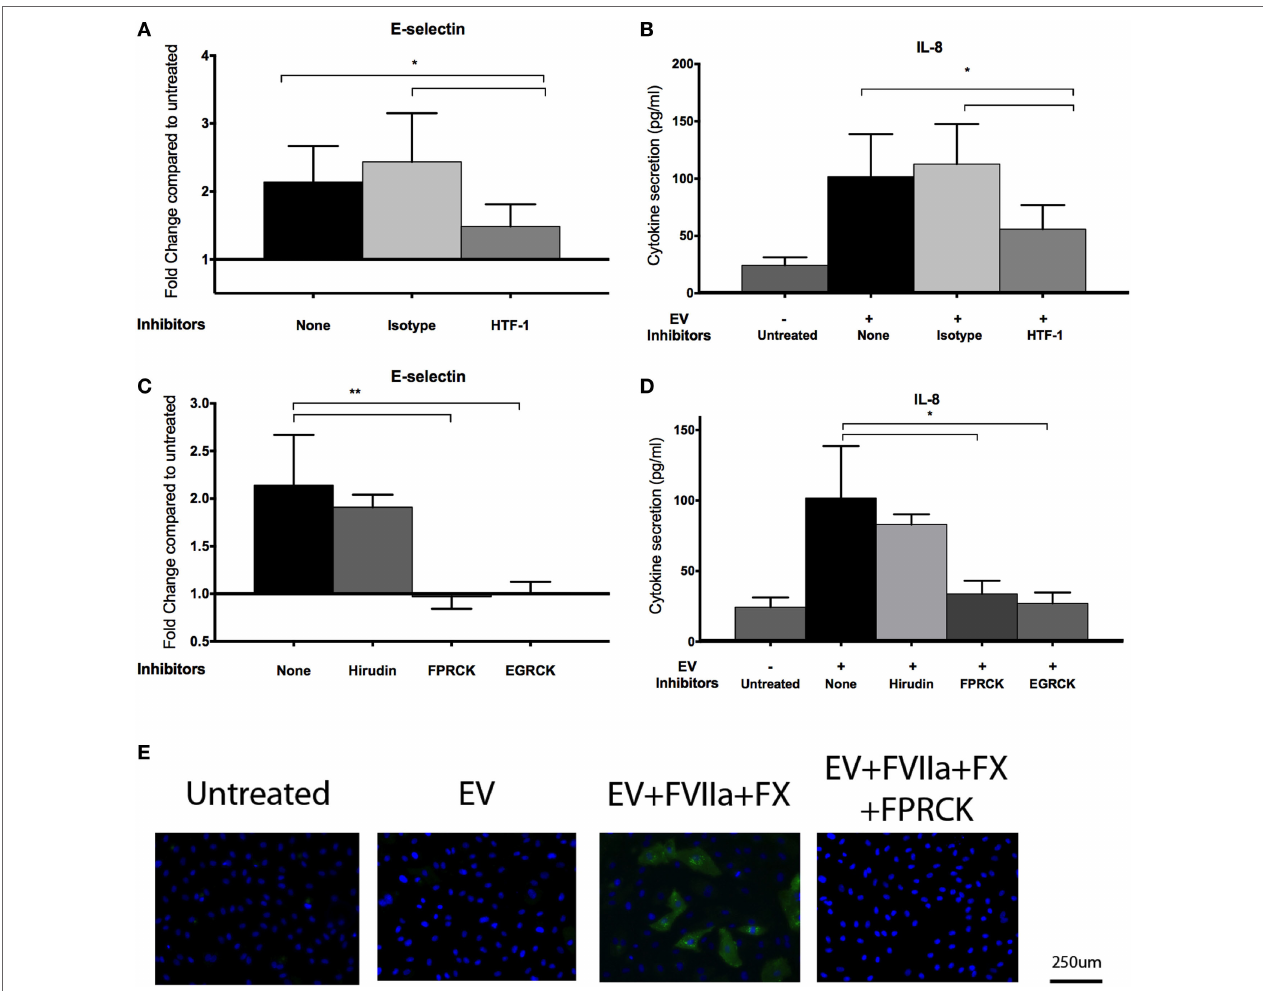
FigUre 4 | MDA-MB-231-derived extracellular vesicle (EV)-induced upregulation of endothelial E-selection expression, and interleukin-8 (IL-8) secretion is tissue factor (TF) and activated factor X (FXa) dependent. (a,B) To inhibit TF, MDA-MB-231-derived EVs were pretreated with 10 µg/ml HTF-1 (anti-TF antibody) or isotype control for 30 min before pretreatment with factor VIIa (FVIIa) and FX, followed by incubation with E4 + human umbilical vein endothelial cells (HUVEC) for 6 h with FVIIa and FX. E-selectin expression (a) and IL-8 secretion (B) were measured after the treatments ( n = 6). (c,D) A thrombin inhibitor, hirudin (10 U/ml), and FXa inhibitors, FPRCK and EGRCK (40 µM), were added with the EV. E-selectin expression (c) and IL-8 secretion (D) were measured after the treatments ( n = 3). * p < 0.05, ** p < 0.01. (e) After incubation with MDA-MB-231-derived EV, E4 + HUVEC were fixed and immunostained with an antibody against E-selectin (green) to evaluate upregulation with immunofluorescent microscopy. Nuclei were counterstained blue with DAPI. Experiments were done in